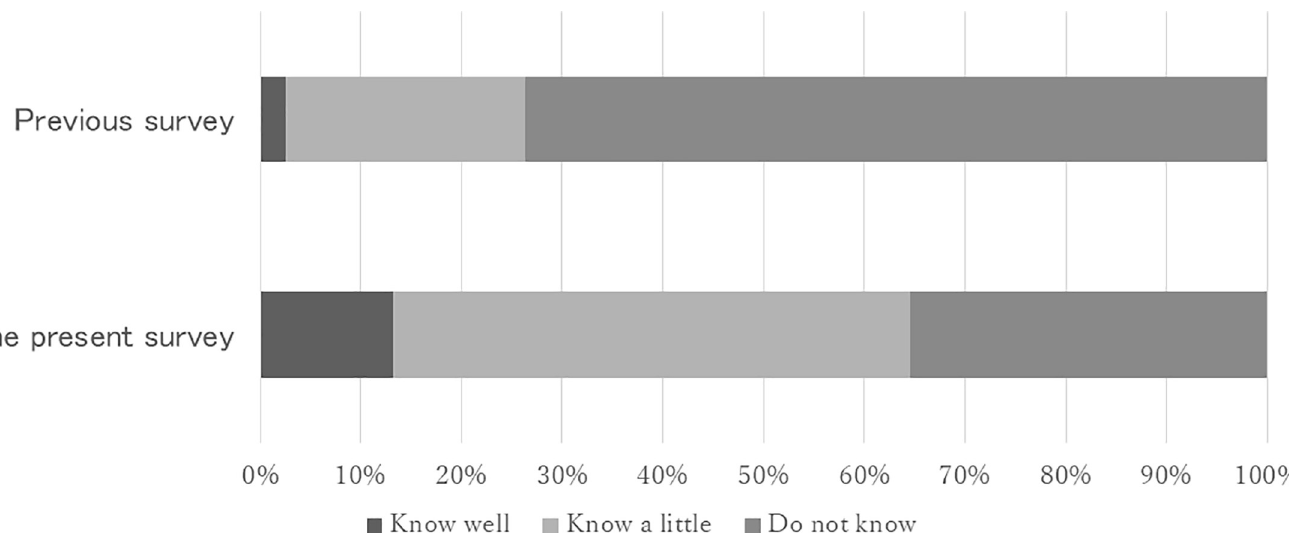
PLOS ONE | https://doi.org/10.1371/journal.pone.0197639 October 15,